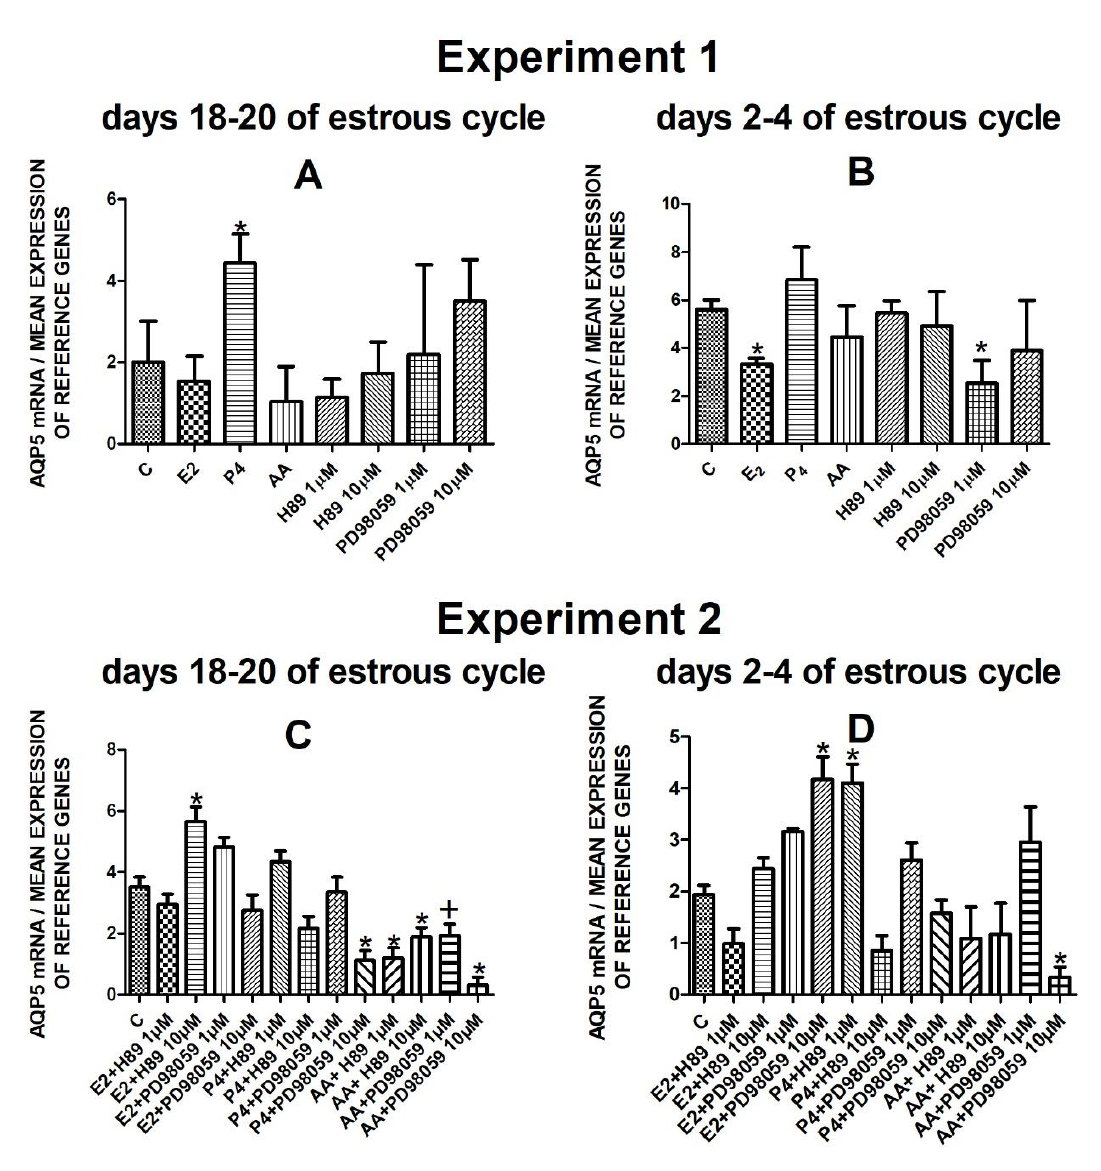
Figure 3. The influence of estradiol (10 nM), progesterone (10 − 6 M), arachidonic acid (10 − 5 M), and kinase inhibitors H89 (1 µ M, 10 µ M) and PD98059 (1 µ M, 10 µ M) and a mix of these factors on Aquaporin 5 mRNA expression (Experiment 1: ( A , B ), Experiment 2: ( C , D )) in the porcine luminal epithelial cells from days 18–20 and 2–4 of the estrous cycle. The gene expression was determined by quantitative real-time PCR. Results are reported as the means ± S.E.M. ( n = 5). Bars with different superscripts differ ( p < 0.05) and are marked by (*), tendency ( p < 0.1) and are marked by plus (+).